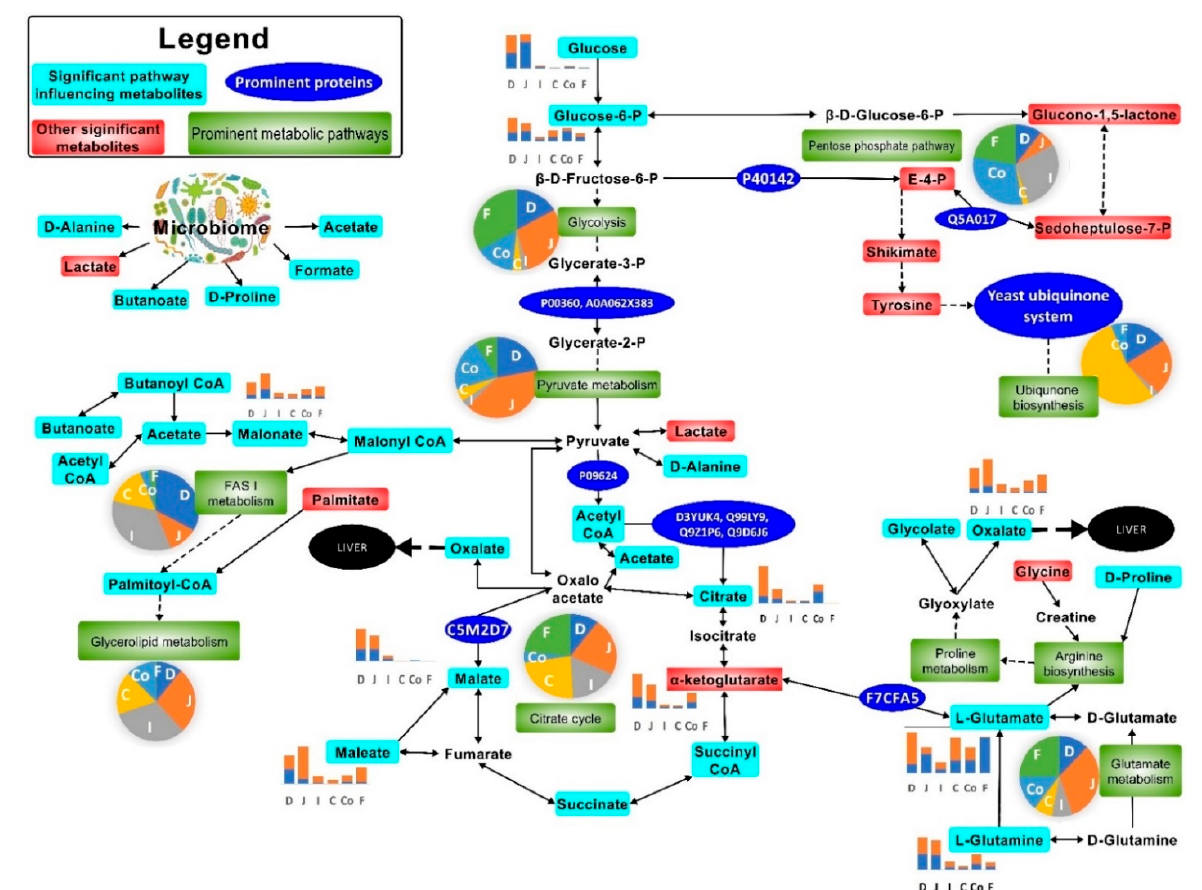
Figure 7. Most prominent metabolic activities in the mouse gut upon Cryptosporidium infection. The pie charts indicate the relative impact of pathways in the duodenum (D), jejunum (J), ileum (I), caecum (C), colon (Co), and faeces (F). The bar graphs show perturbed metabolites in uninfected ( ) and Cryptosporidium ( ) infected mice. Note: Please refer to Figure S8 for a more descriptive pathway chart.